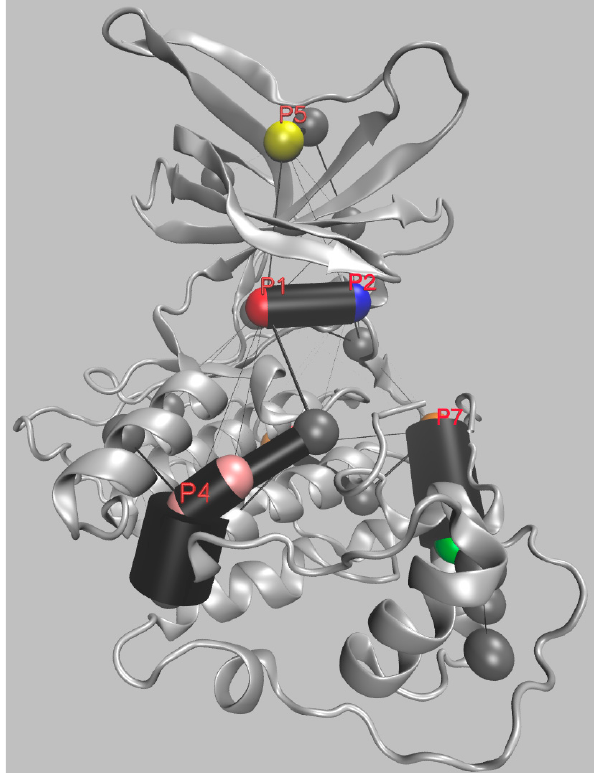
Figure 3. Front view of GSK-3 β , with the main pockets (indicated as P1, P2, P4, P5 and P7) found by Pocketron represented as spheres. The spheres are color-coded, as in Figure 2, when located in the same region as the pockets identified by Palomo et al. Otherwise, the spheres are in gray or green. Black cylinders connect the pockets involved in crosstalk, with a radius proportional to the frequency of the crosstalk.